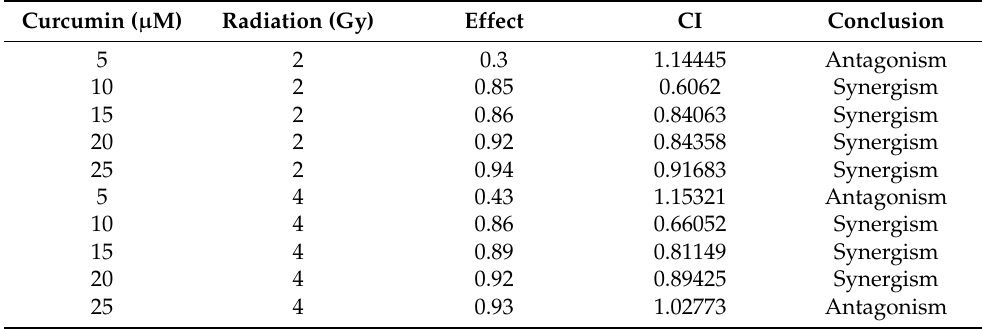
Table 1. Assessment of combinatorial effect of curcumin and radiation in U87 cells. CI was deter- mined by CompuSyn software.